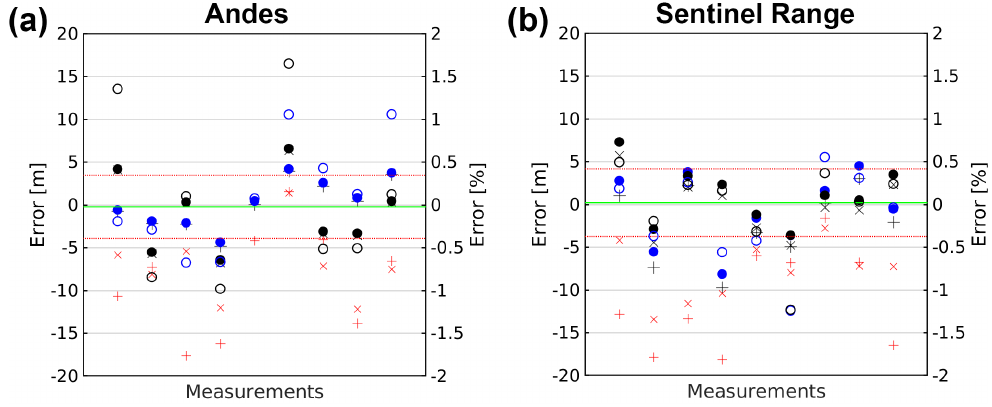
Figure 16. Errors in shadow-derived heights measurements at the Andes ( a ) and Sentinel Range ( b ) validation sites. Errors correspond to the difference between shadow-derived and GNSS mea- surements. Circles represent measurements done with the presented methodology, solid circles corresponds to the error in meters (left axis) and empty circles to the relative error (right axis). Blue and black circles represent nadir- and backward-looking bands respectively. The solid green line shows the mean value of errors, and the red dotted line shows the standard deviation of errors around the mean. Thin markers (“+” and “ × ” symbols) represent solutions neglecting atmospheric refraction (black) or fine shadow adjustment (red), in this case nadir- and backward-looking bands are represented by “+” and “ × ” symbols